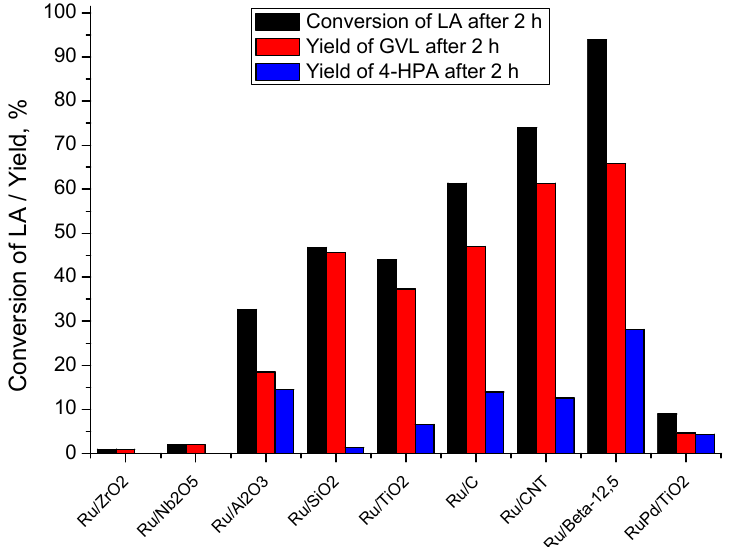
Figure 4. Conversion of LA and yield of GVL ( γ -Valerolactone) and 4-HPA after 2 h batch time. Reaction conditions: 90 °C, 45 bar H 2 , C LA,0 = 0.6–0.7 mol/L, m cat = 0.06 g, stirring rate = 2000 rpm.